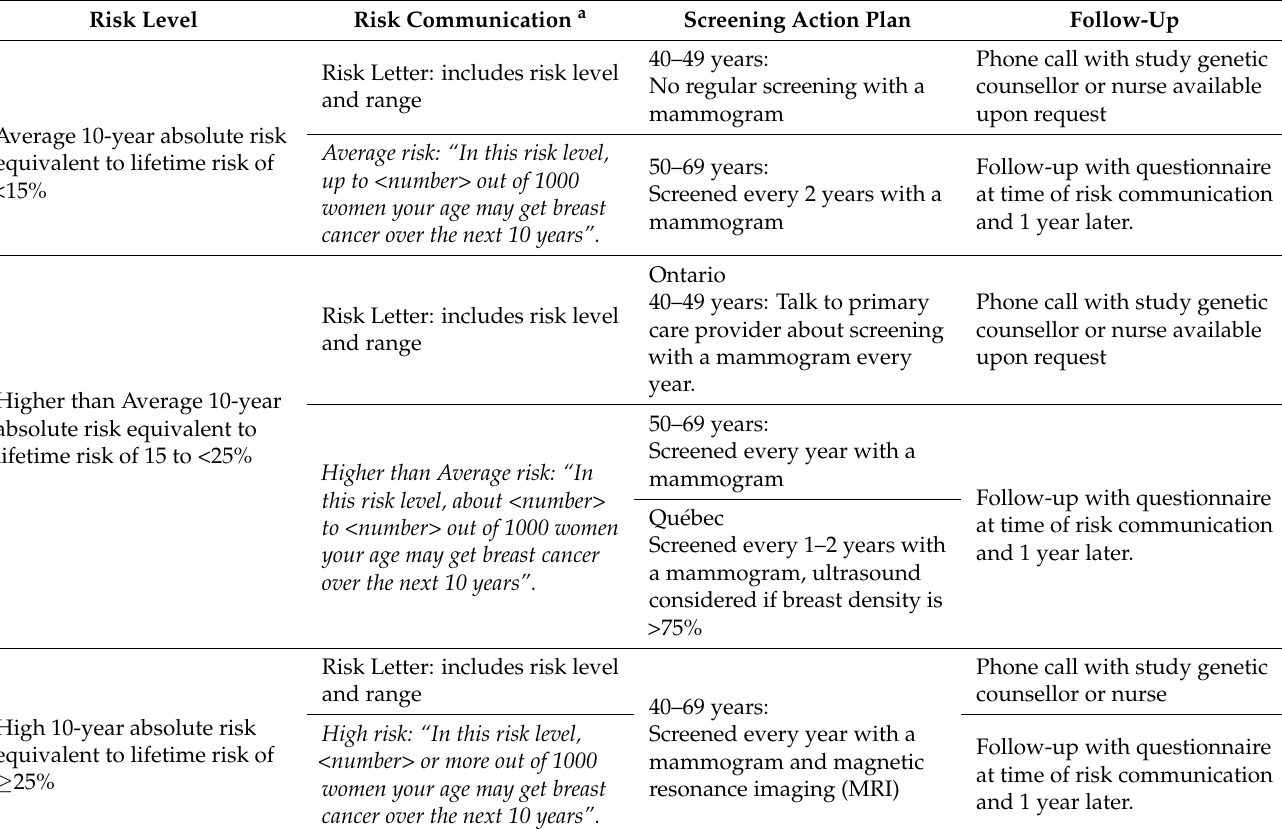
Table 1. Overview of screening action plan, risk communication & follow-up procedures by estimated risk